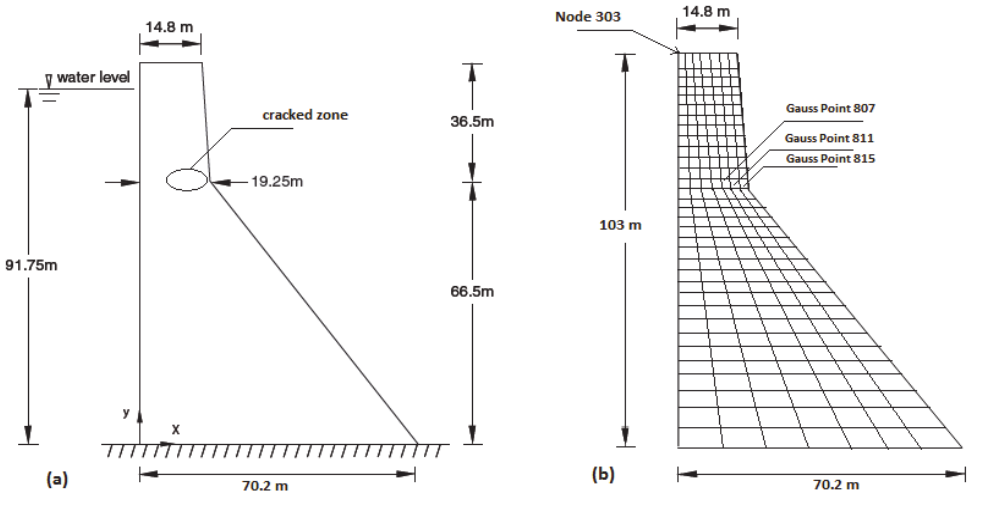
Figure 4: Geometric properties of the KOYNA dam.